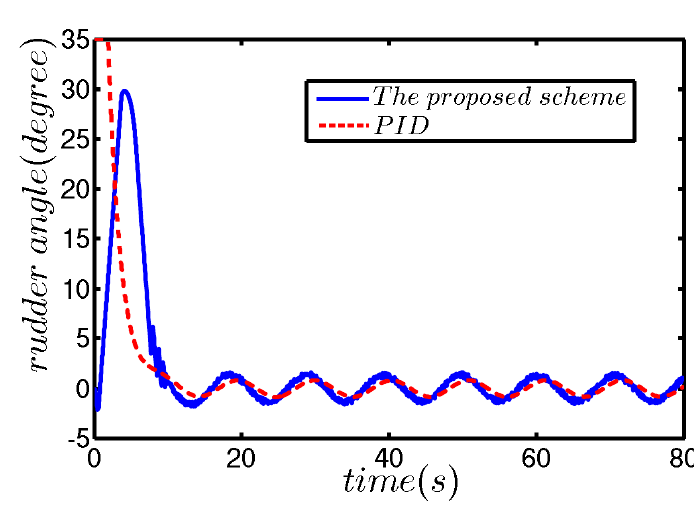
Figure 4. The curves of course angle under weak disturbance.